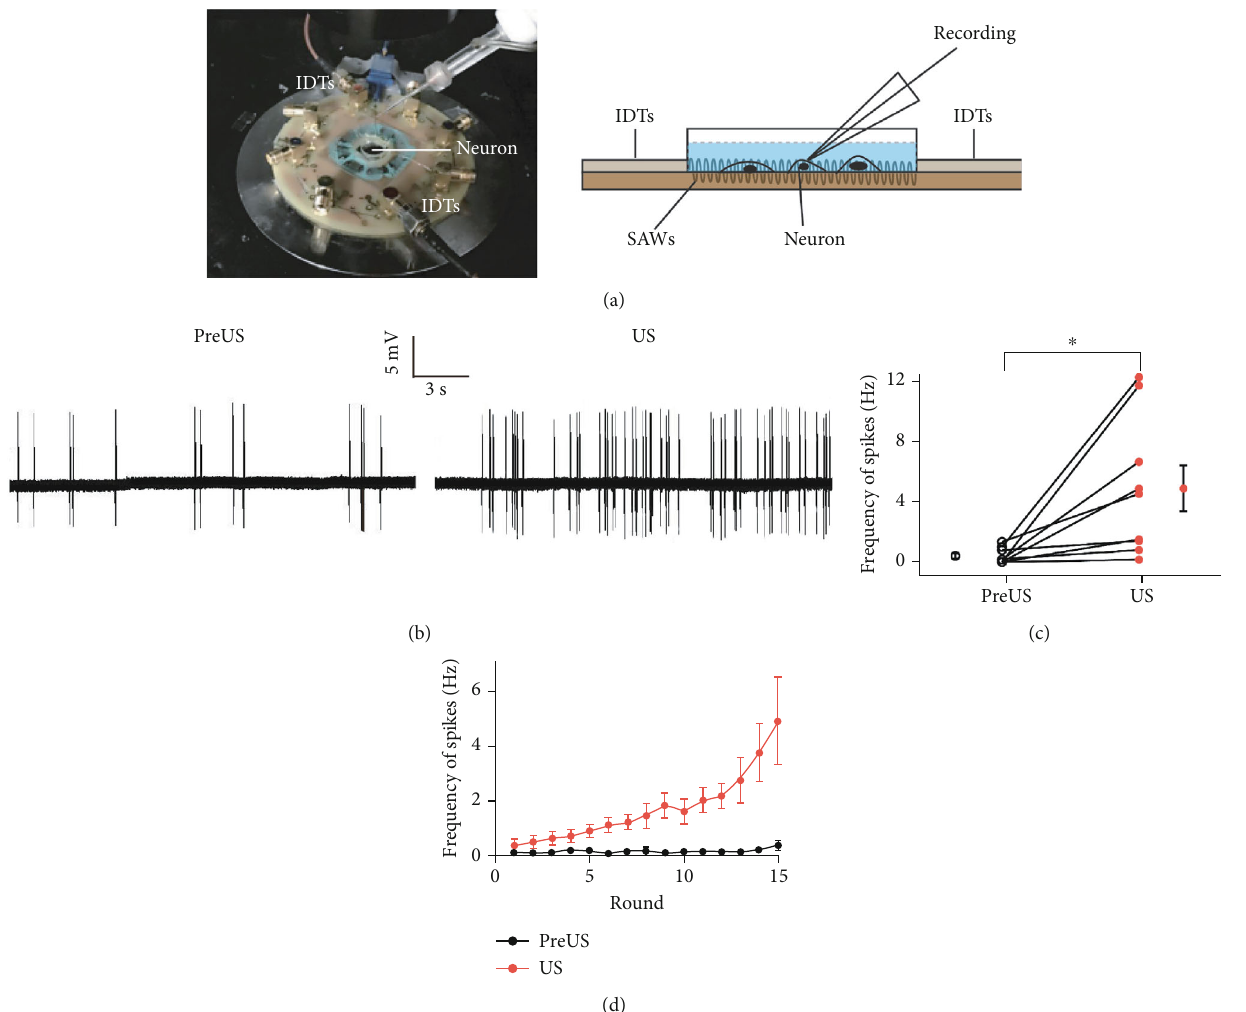
Figure 4: High-frequency ultrasound activates cultured auditory cortical neurons. (a) The ultrasound neural stimulation chip. Left, the photograph of the ultrasound neural stimulation chip used in the experiment. Right, a schematic illustration of the chip. The ultrasound neural stimulation chip consists of miniaturized interdigital transducers (IDTs) and an agar plate. The responses of neurons to surface acoustic waves (SAWs) were recorded. (b) The representative traces show the action potentials of a cultured cortical neuron before (pre- US) and during (US) US stimulation. (c) The changes of frequencies of action potential before (pre-US, open circles) and during (US, red circles) US stimulation for nine neurons. The mean values are also shown. Data are presented as the mean ± SE . ∗ p < 0 : 05 , n = 9 , paired t -test. (d) The frequency of action potentials increased with the repeated US stimulation. Data are presented as the mean ± SE , n = 9